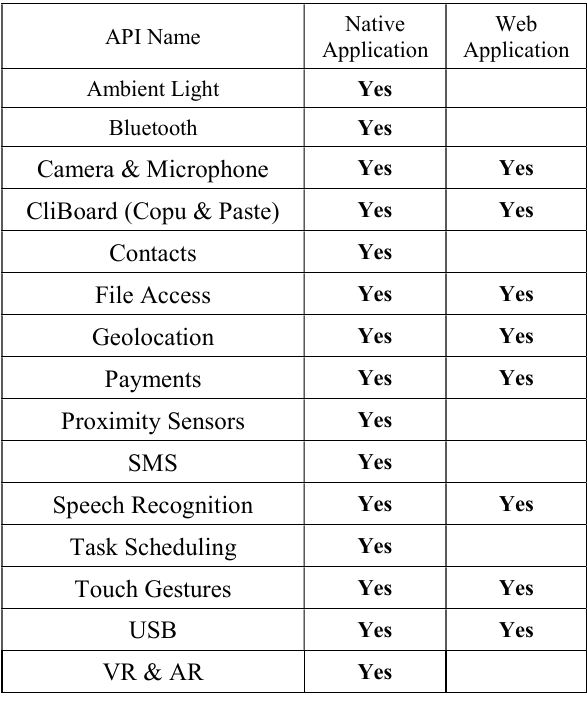
Table 2 A Comparison between Native and Web in accessing major mobile